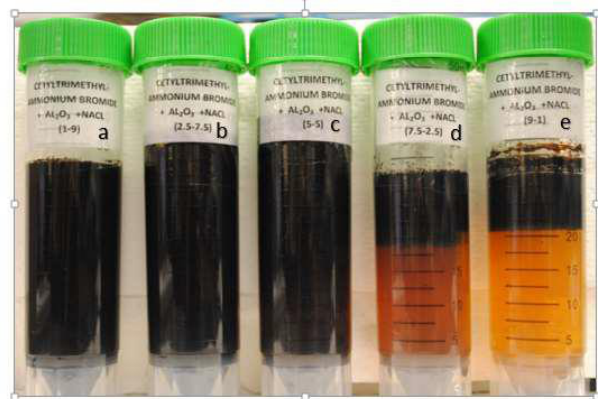
Figure7—CTAB with Al